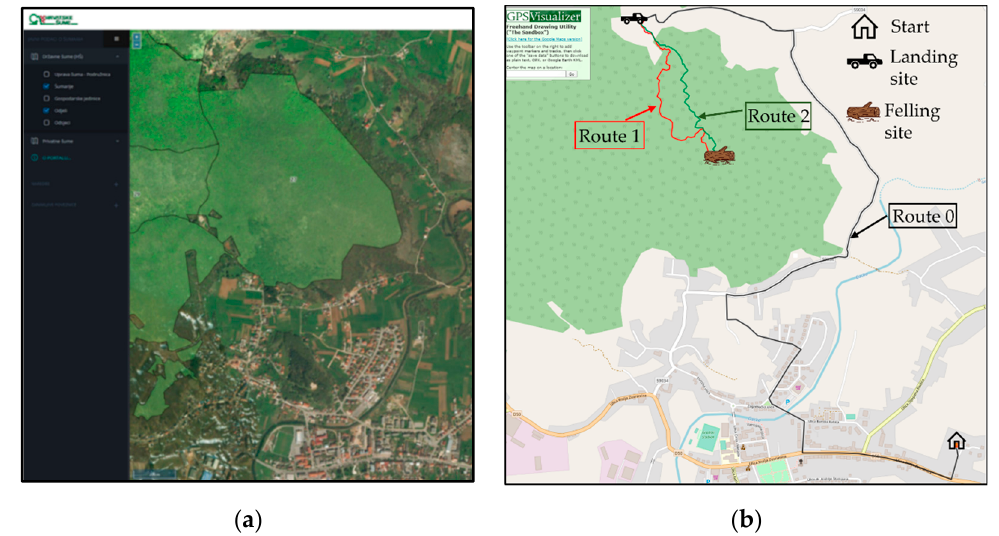
Figure 8. Driving routes for the skidder’s work day: satellite image (a) and map layout